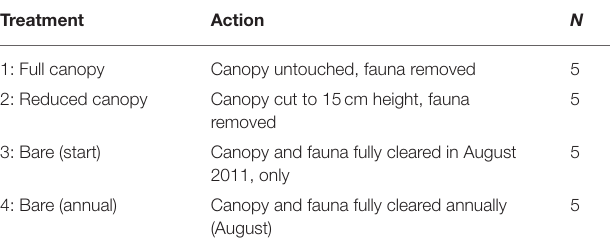
TABLE 1 | The four treatments applied at each of five replicate sites in the inner Kobbefjord mid intertidal, August 2011. Treatment Action